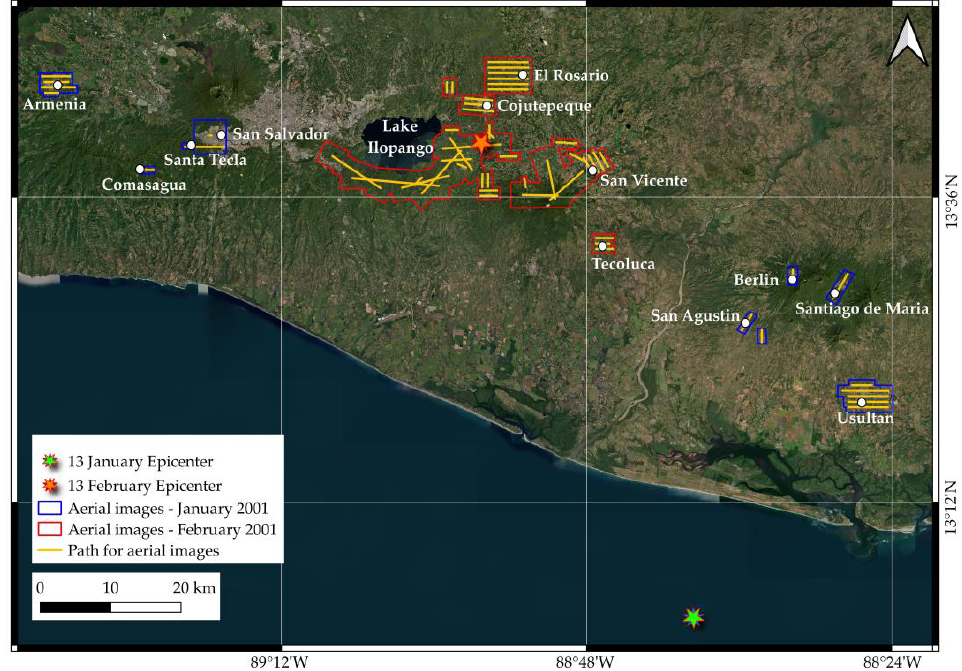
Figure 4. Positions of the epicenters, paths and areas covered by the aerial images employed to map the landslides that occurred in January and February 2001.